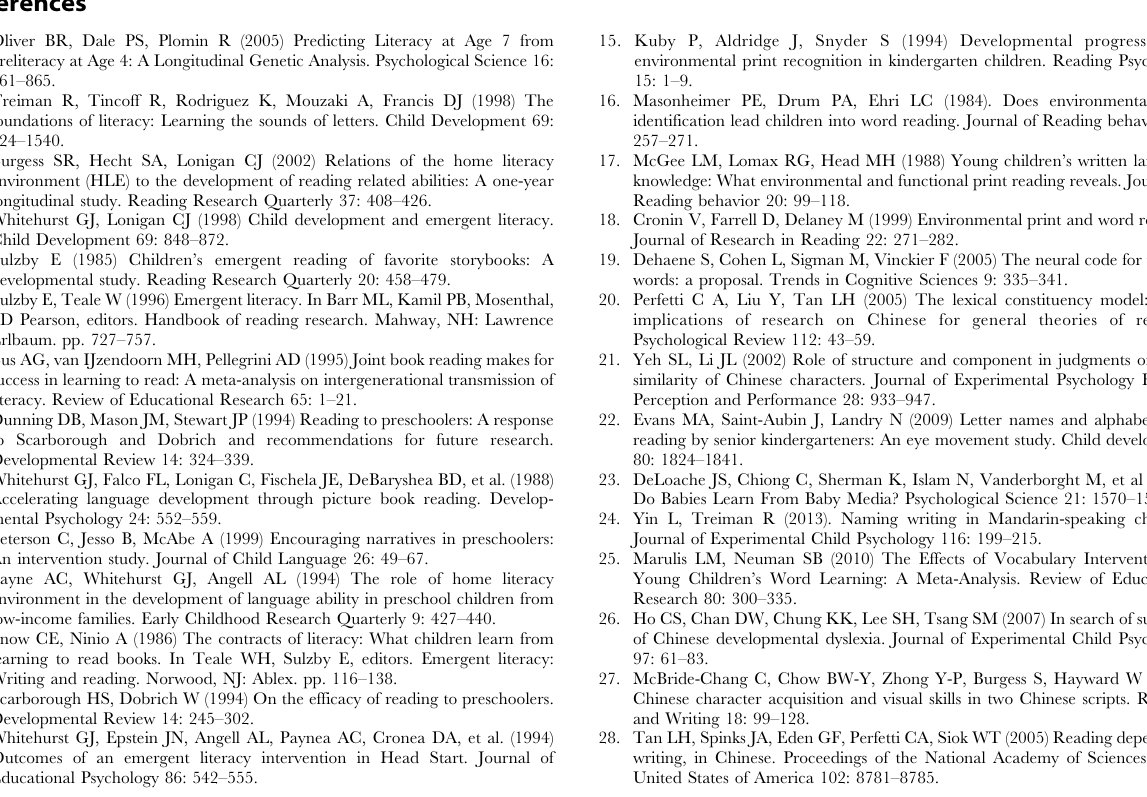
Table S1 Results of ANOVAs for total scores of each